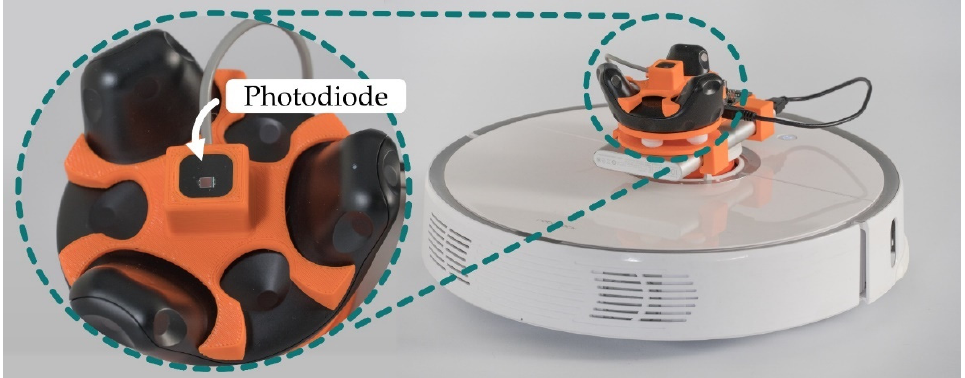
Figure 9. The Vive tracker was mounted to the top of the Roborock 55 with care taken to avoid blocking the LIDAR. The VLP tag was mounted in the center of the tracker without blocking the Vive’s photodiodes. Both the Vive tracker and the VLP tag were powered using a USB power